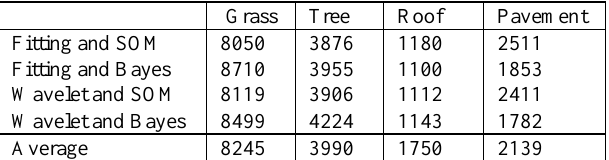
Table 2: Number of points in classes